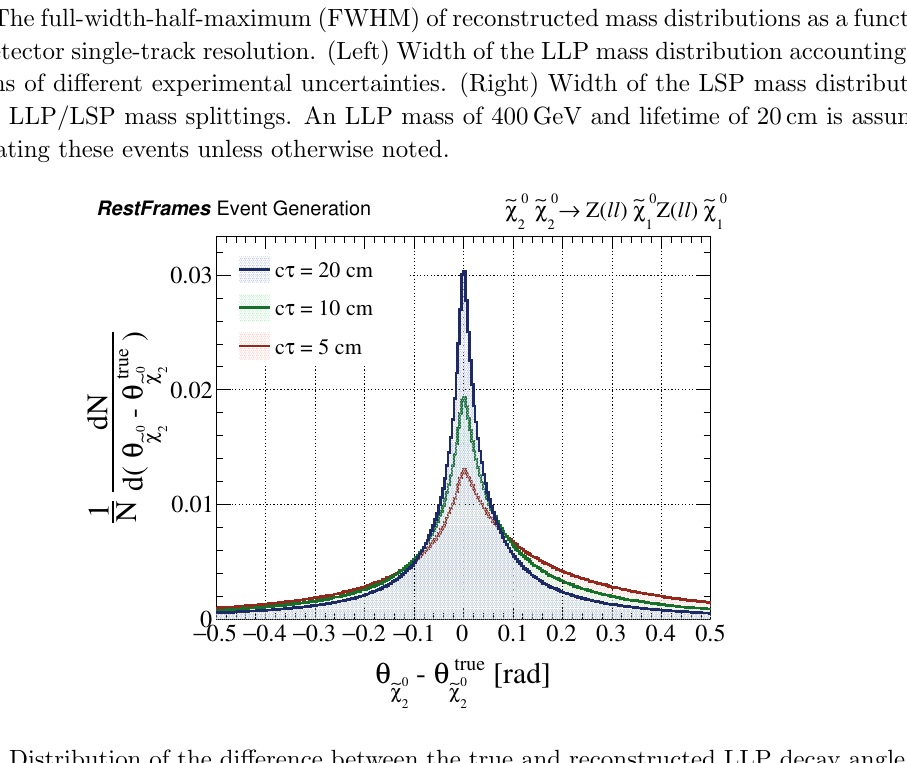
Figure 10 . Distribution of the di(cid:11)erence between the true and reconstructed LLP decay angle for di(cid:11)erent neutralino